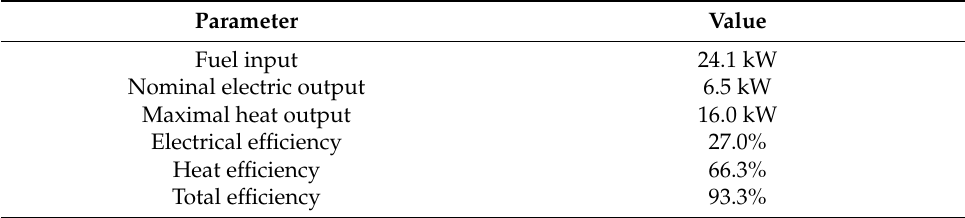
Table 1. Technical data of CHP unit [32].